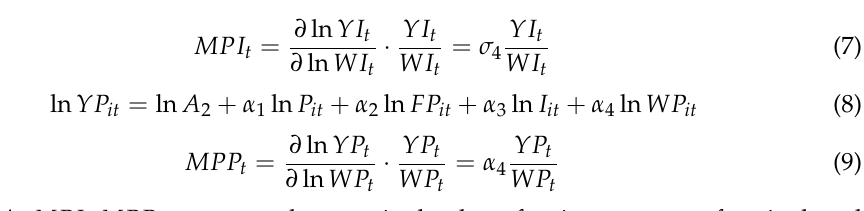
Table 1. Categories of households’ water use.